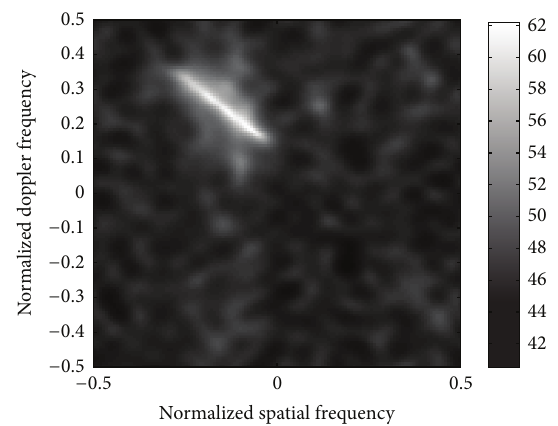
Figure 1: The estimated interference spectrum using the Mountain Top